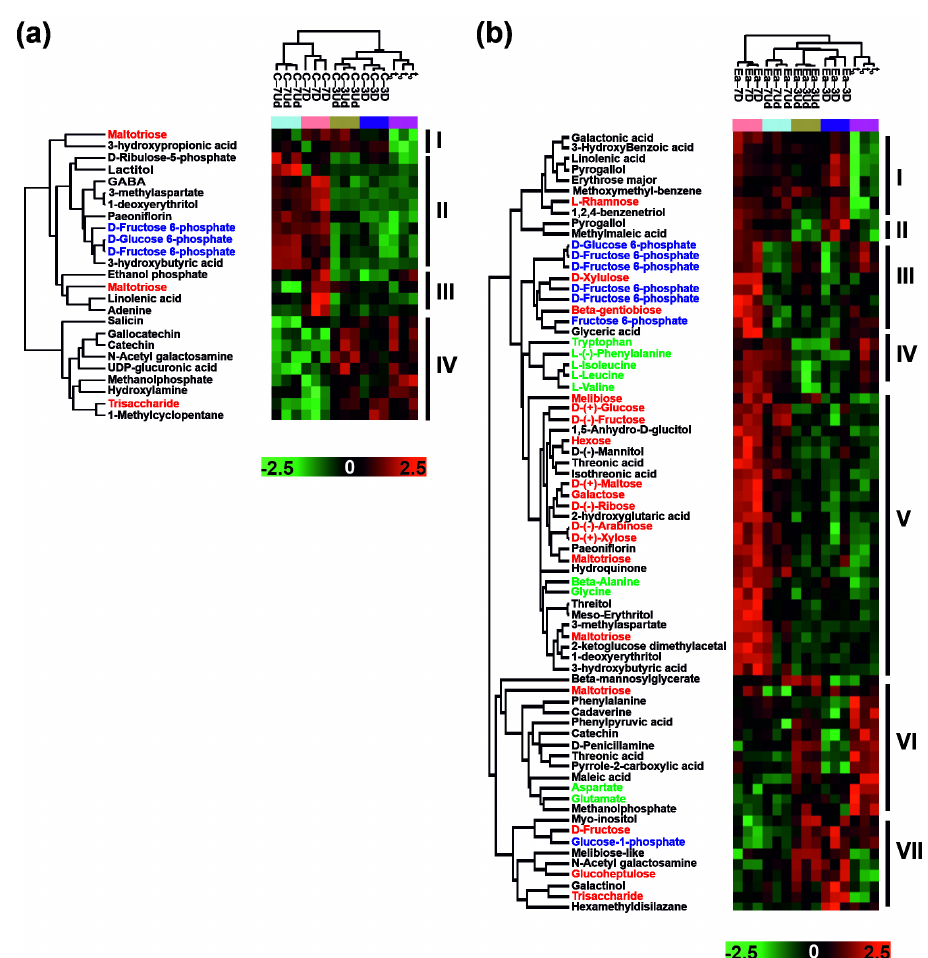
Figure 6. Heatmap analysis combined with hierarchical cluster analysis demonstrating metabolites that were differentially abundant between analyzed treatments ( p < 0.05, ANOVA) in cotyledons ( a ) and embryonic axes ( b ). Green names: amino acids; red names: carbohydrates; blue names: phosphorylated carbohydrates; black names: other compounds. Intensity values were log 2 transformed, batch corrected and Z scored row-wise. Green reflects minimal abundance, whereas red indicates maximal abundance on the scale. Clusters designated by hierarchical analysis are marked with Roman numbers separately for cotyledons and embryonic axes.